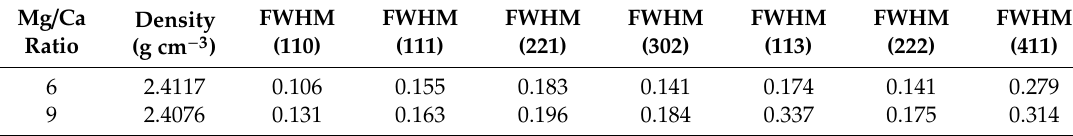
Figure 2. XRD analyses of minerals in the experimental groups after 14 days of cultivation. Table 1. Parameters of monohydrocalcite at Mg / Ca molar ratios of 6 and